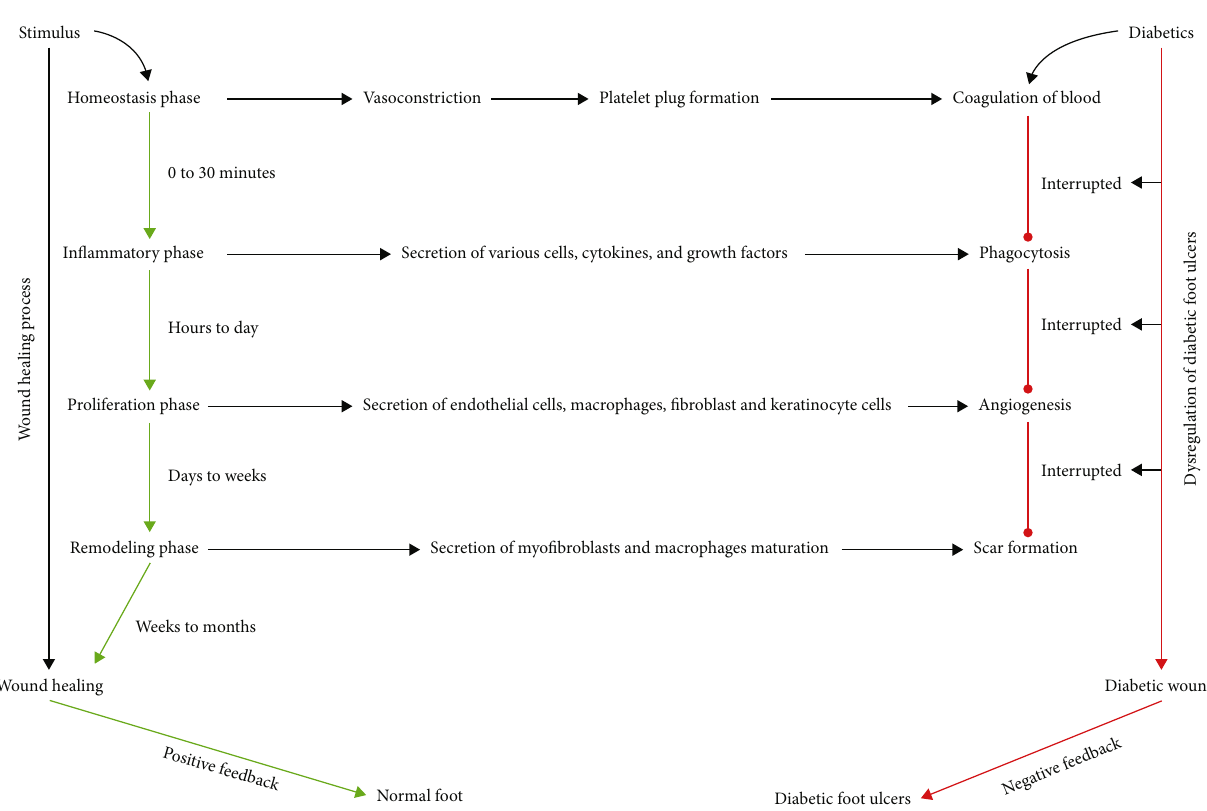
Figure 2: Mechanism of wound healing and dysregulation of diabetic foot ulcers. The stages of wound healing and dysregulation of diabetic foot ulcers: Wound healing begins with hemostasis phase, where a platelet plug prevents blood loss and a preliminary fi brin matrix is formed. In fl ammation phase ensues to avoid infection (phagocytosis), with the secretion of neutrophils, macrophages, cytokines, and growths factors to remove cell debris. During the proliferative phase, endothelial cells, macrophages, fi broblast, and keratinocytes cells accelerate angiogenesis by closing the wound gap and replacing the initial fi brin clot with granulation tissue. Finally, the remodeling phase causes overall wound contraction by secretion of myo fi broblasts and macrophages maturation. In diabetic wounds, active diabetes interrupts routine wound-healing phases, leading to poor